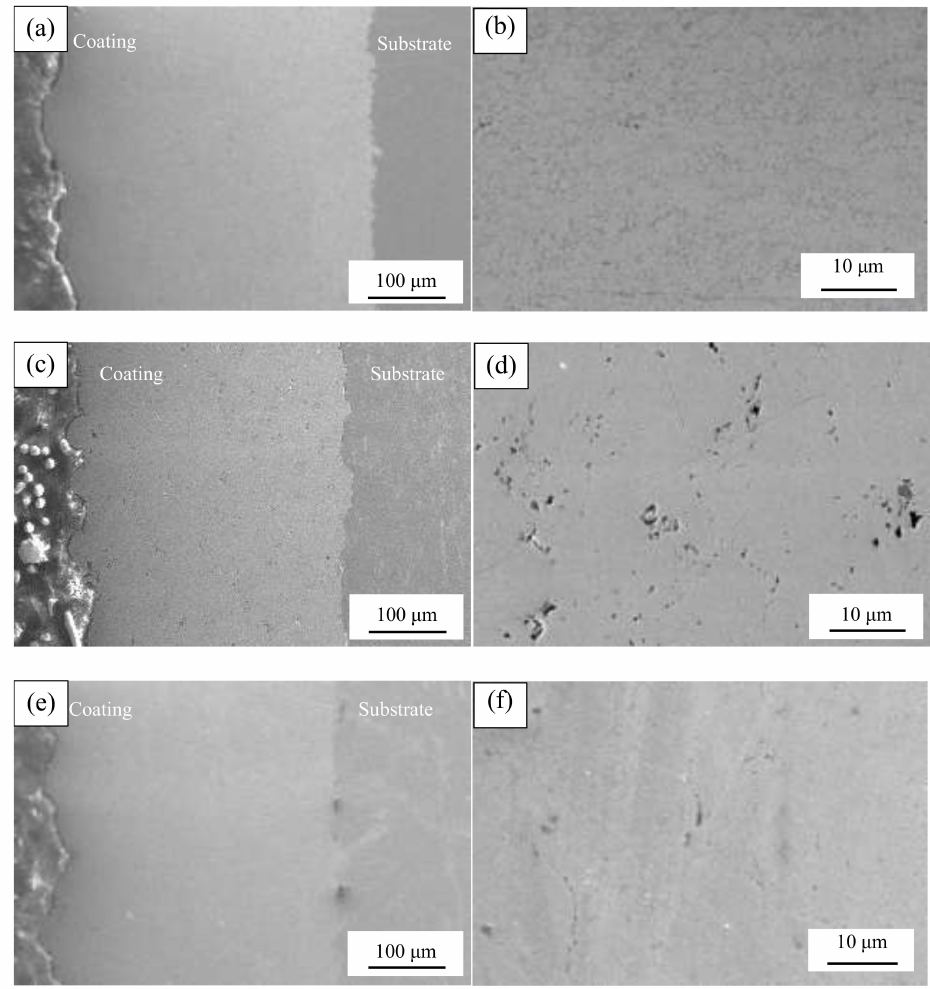
Figure 2. Cross-section morphology of the coatings: ( a , b ) WC-10Ni; ( c , d ) Ni45; ( e , f )